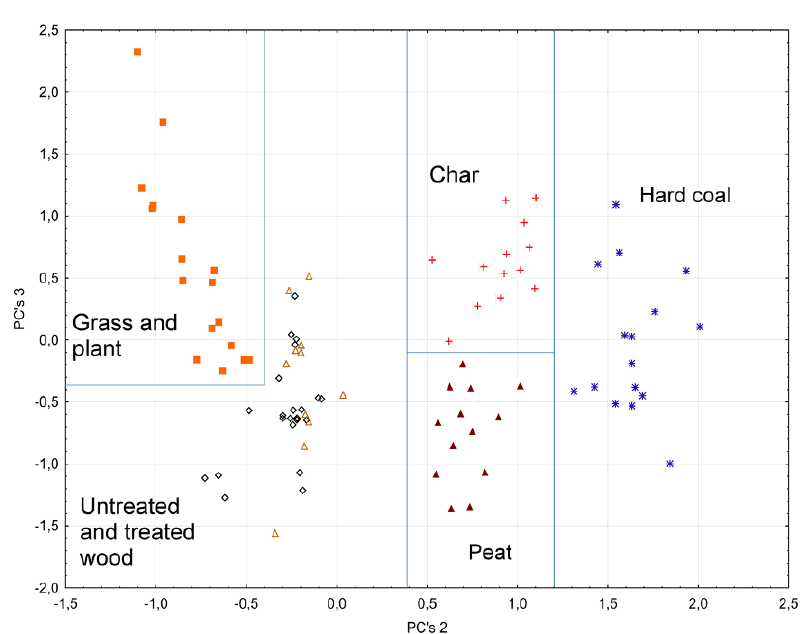
Figure 5. Plot of Principal Component Analysis of analysed materials.